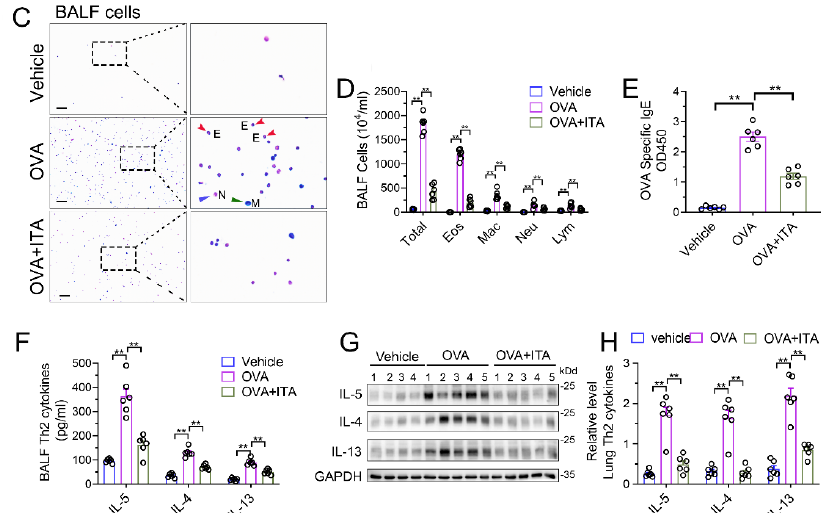
Figure 2. Exogenous itaconate attenuates OVA − induced allergic airway inflammation. ( A ) Protocol for the establishment of OVA-induced allergic airway inflammation and treatment of itaconate. ( B ) Representative whole lung sections stained with HE and PAS, scale bar: 500 µ m. A magnified version of the panel can be found in Supplementary File S1: Figure S3. ( C ) Representative images of BALF cells stained with Wright–Giemsa solution. E: red arrows indicate eosinophils, M: green arrow indicates macrophage and N: blue arrow indicates neutrophil. Scale bar: 100 µ m. ( D ) The number of total inflammatory cells, eosinophils, macrophages, neutrophils and lymphocytes in BALF. ( E ) The optical density value (OD value) measured at 450 nm represents the level of IgE in serum. ( F ) The level of Th2 cytokines IL-5, IL-4 and IL-13 in BALF. ( G ) Representative blots showing the protein expressions of Th2 cytokines IL-5, IL-4 and IL-13 in lung tissues from vehicle, OVA and OVA+ITA groups. ( H ) Quantification of the expression of IL-5, IL-4 and IL-13 in the lung as referencing to GAPDH. Cropped blots are shown, and Supplementary File S2: Figure S3 presents the full-length blots. Data expressed as means ± SEM ( n = 6). ** p < 0.01.